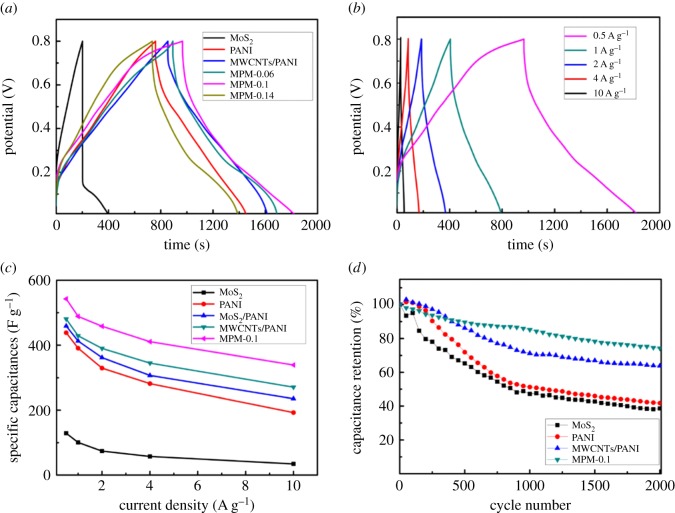
(a) GCD plots of MoS2, PANI, MWCNTs/PANI, MPM-0.06, MPM-0.1 and MPM-0.14 at a current density of 0.5 A g−1 in 1 M H2SO4; (b) GCD plots of MPM-0.1 at different current densities. (c) Variation of the specific capacitance with different current density for MoS2, PANI, MoS2/PANI, MWCNTs/PANI and MPM-0.1 nanocomposites. (d) Cycling performance of MoS2, PANI, MWCNTs/PANI and MPM-0.1 at 1 A g−1 for 2000 cycles.